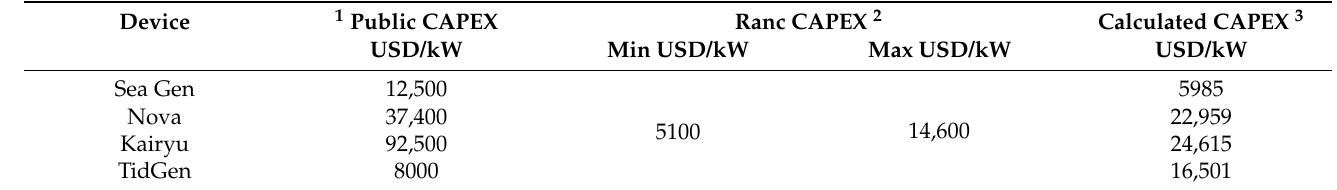
Table 5. Comparison of public and calculated LCOE.